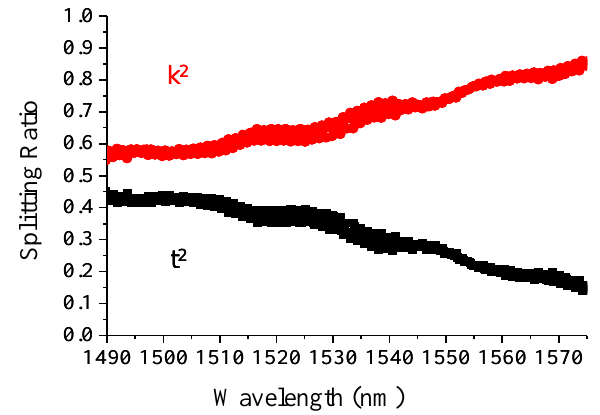
Figure 4. The MMI splitting ratio under TM